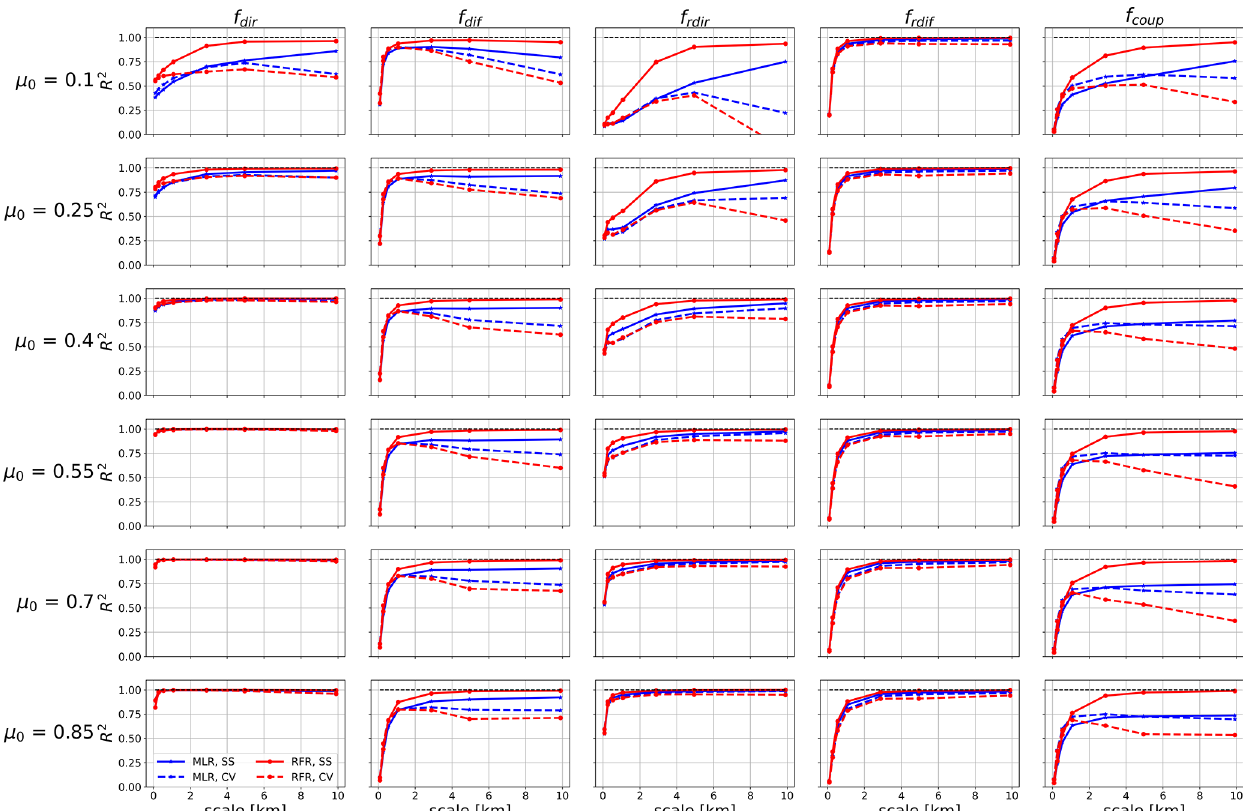
Figure 7. Coefficient of determination R 2 for the two different predictive models: multiple linear regression (MLR, blue lines) and random forest regression (RFR, red lines). Results are reported for varying averaging scales and cosines of the solar zenith angle ( µ 0 ). The models were trained over the Peru site and tested over the same site (SS, continuous lines) and over the independent eastern Alps site for cross validation (CV, dashed